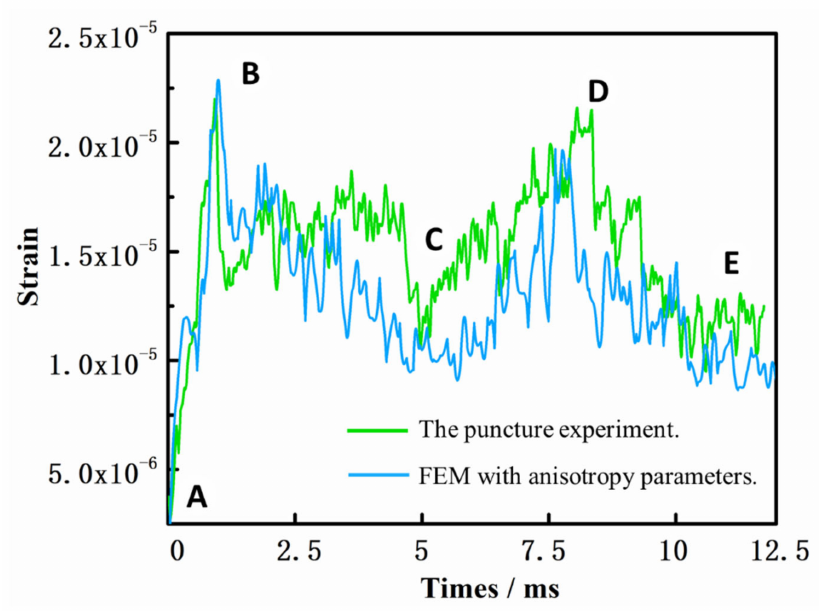
Figure 14. Strain results obtained using the finite element method (FEM) with anisotropy parameters. (The curves marked A to E in the figure represent different stages in the puncture process.).